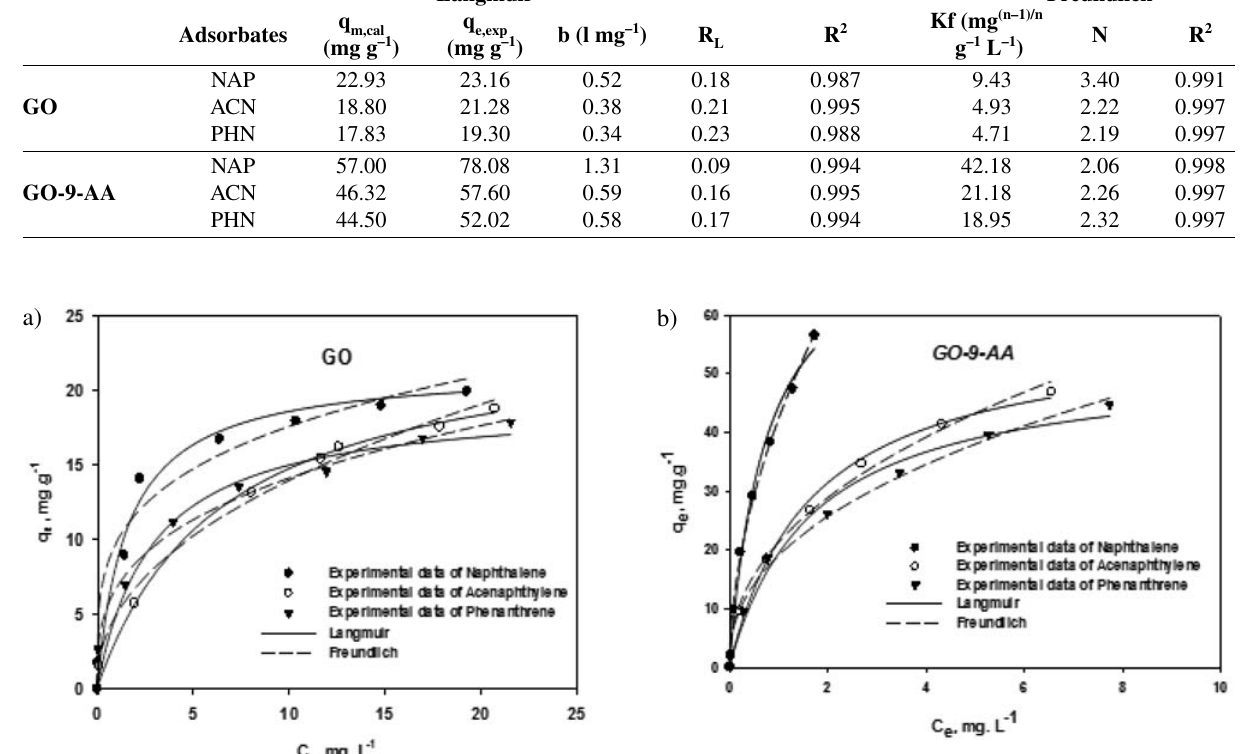
Table 2. Isotherm parameters for NAP, ACN, and PHN adsorption onto GO and GO-9-AA Langmuir Freundlich